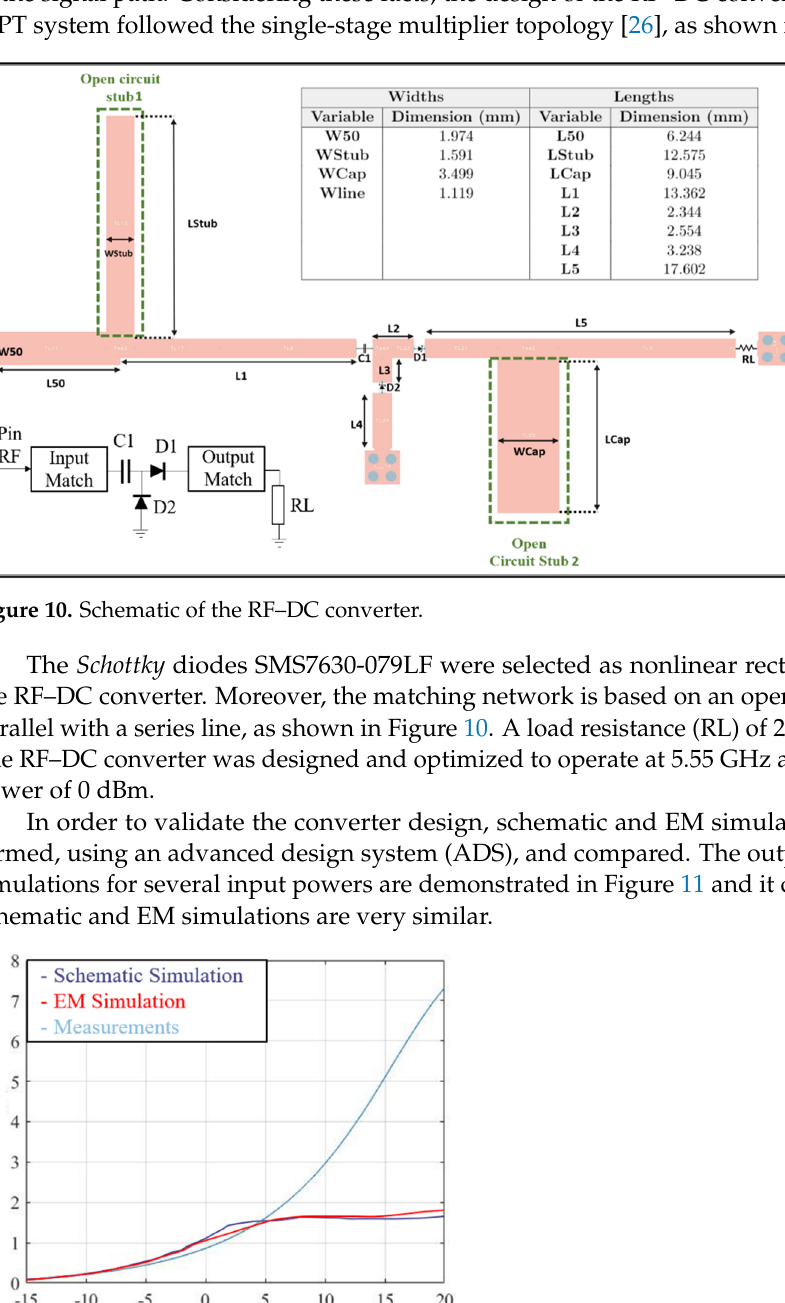
Figure 12. Simulated RF–DC converter circuit efficiency results. Additionally, the RF–DC converter was characterized using VNA to evaluate the circuit reflection coefficient, and the results are depicted in Figure 13. From those results, it can be concluded that, for the intended frequency, 5.55 GHz, the RF–DC converter is matched to 50 Ohm, presenting the reflection coefficient magnitude of − 20 dB. To evaluate the efficiency of the RF–DC converter, a specific setup was utilized. A vector signal generator (VSG) is used to generate an RF signal and is connected to the RF port of the RF–DC converter. The DC port of the converter is attached to a voltmeter to obtain the correspondent DC voltage. Similar to simulations, two different measurements were carried out. First, for several input power values, the RF–DC converter DC output voltage was measured, and the results are shown in Figure 11. Then, the RF–DC efficiency for several input powers